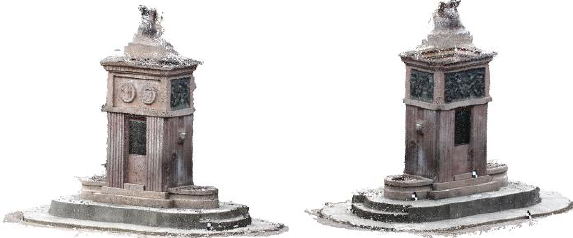
Figure 21. Video based dense point cloud of the monument after filtering.